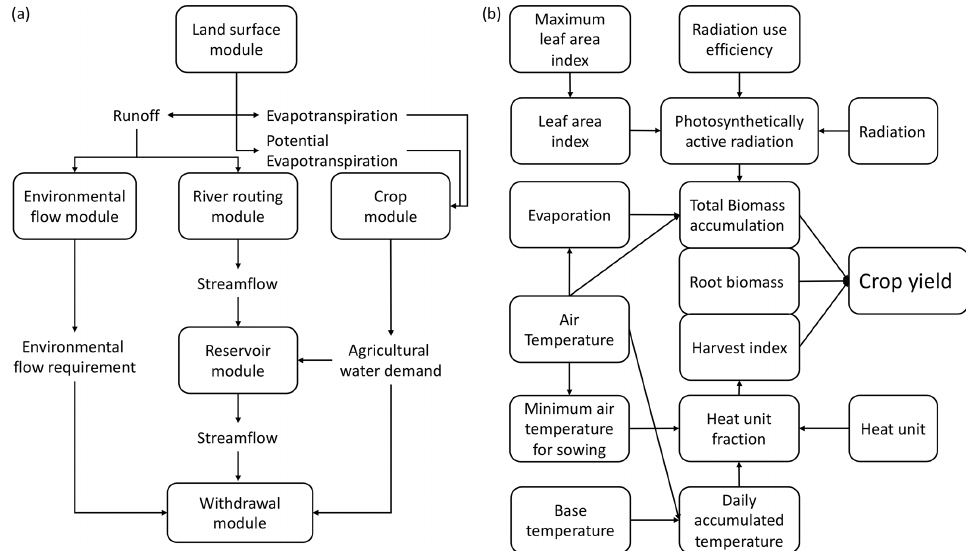
Figure 1. Schematic diagram showing the six submodules (a) and basic biophysical processes of the crop module (b) in the H08 model.